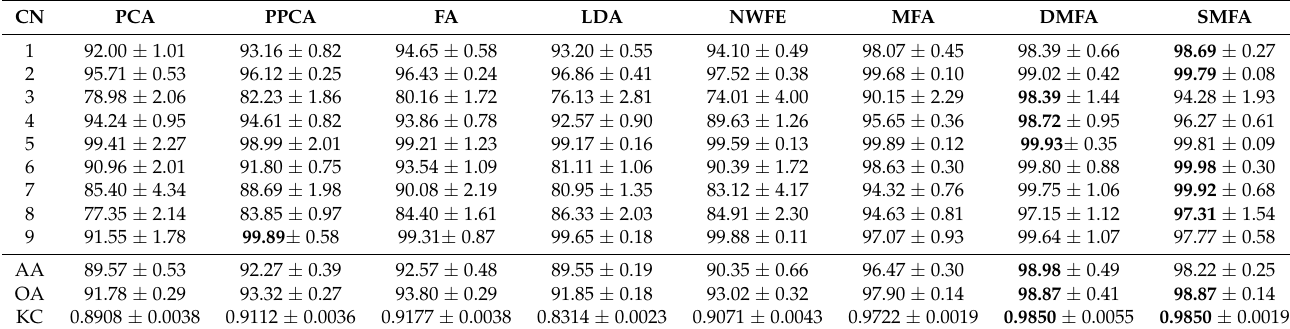
Table 8. The classification results (%) of different DR methods on the University of Pavia dataset, the best results are in bold typeface. The row of each class number (CN) is the mean accuracy ± standard deviation based on ten runs.